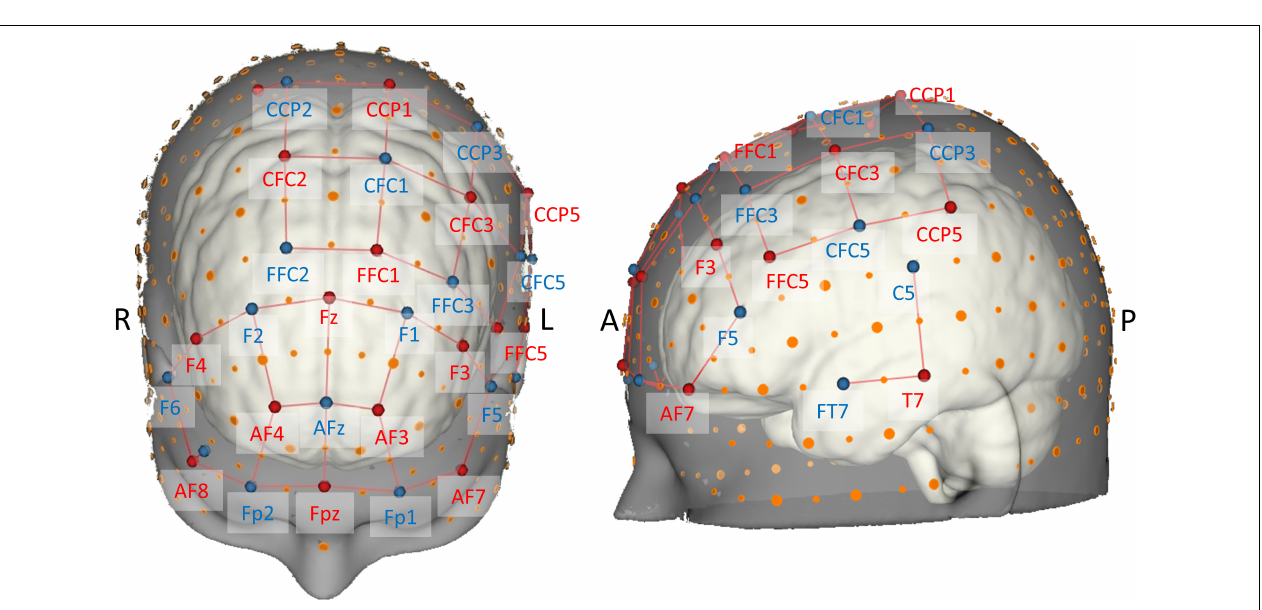
FIGURE 3 | Brain map of the fNIRS head probe covering prefrontal, motor, and temporal regions. International EEG 10-5 coordinates (Oostenveld and Praamstra, 2001) are depicted next to source (red) and detector (blue) optodes. Note the short-distance channels near 10-5 positions AF8 and